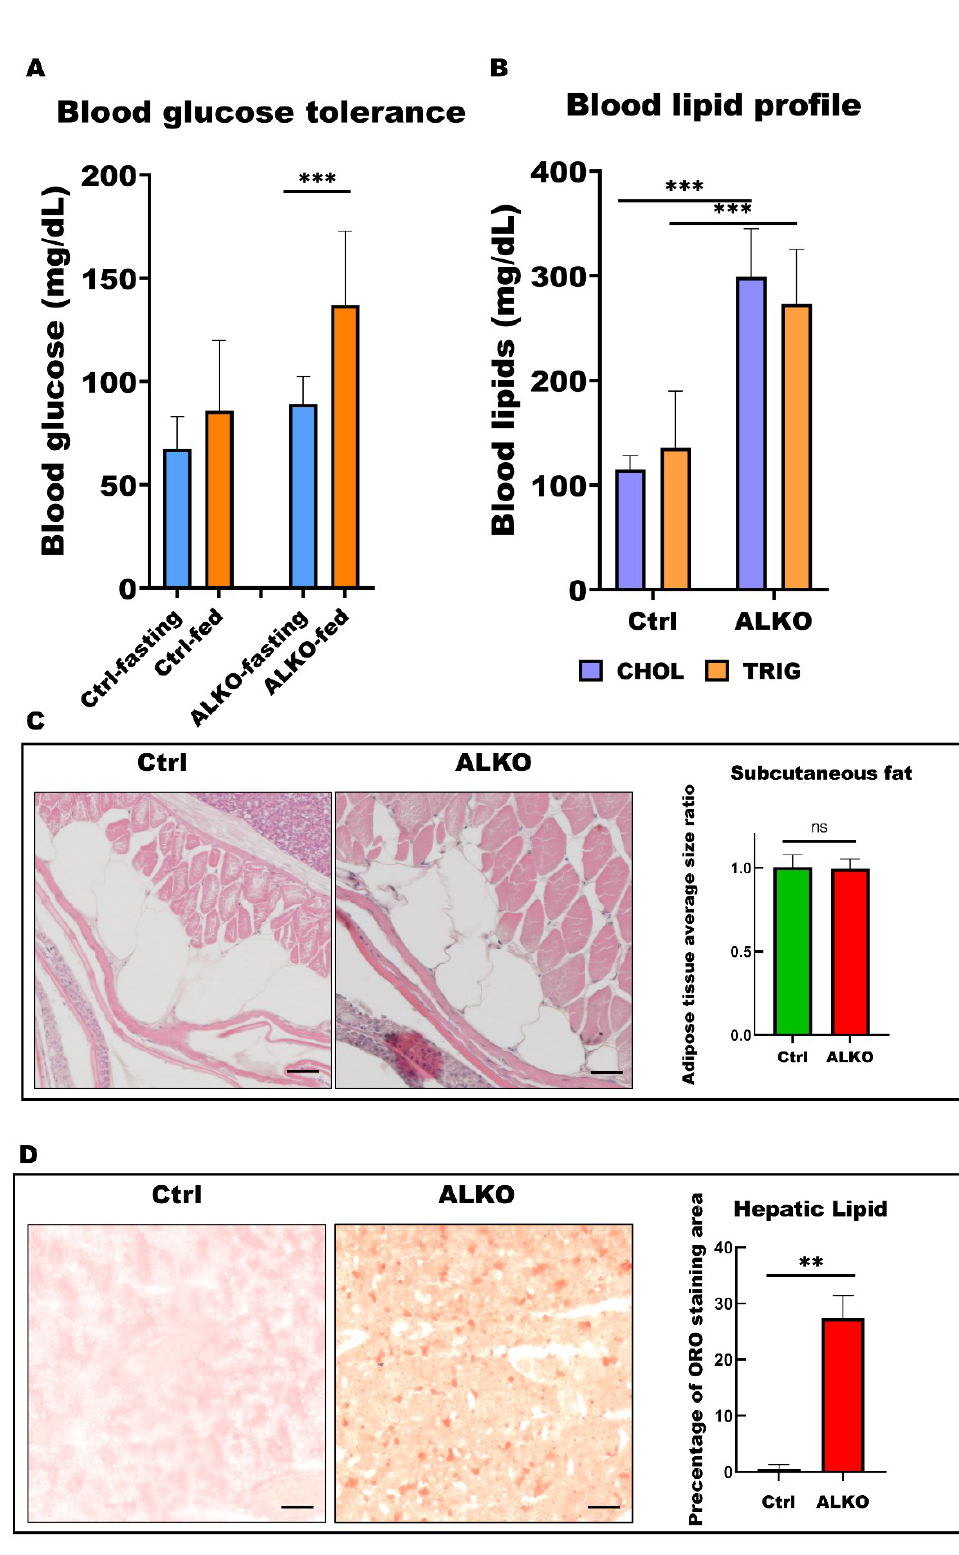
Figure 3. ALKO presented a typical metabolic syndrome outcome in adult. ( A ) Blood glucose contents of control and ALKO adults 5-month post-fertilization (mpf) at fasting and 90 mins after feeding. Values of Ctrl-fasting = 67.3636 ± 15.4872, Ctrl-fed = 85.75 ± 34.0619, ALKO-fasting = 89 ± 13.2581, and ALKO-fed = 136.833 ± 35.9415. ( B ) Blood lipid contents of control and ALKO adults at 5 mpf. CHOL: Total cholesterol content (mg/dL); TRIG: Total triglyceride content (mg/dL). Values of CHOL in Ctrl = 115 ± 13.2288, and ALKO = 299 ± 45.9239. Values of TRIG in Ctrl = 135.667 ± 54.3722, and AKOL = 273 ± 52.5071. ( C ) Characterization of subcutaneous fat in ALKO and control at 5 mpf. Scale bar: 50 μm. Values of adipose tissue average size ratio in Ctrl = 1.0041 ± 0.0738, and ALKO =